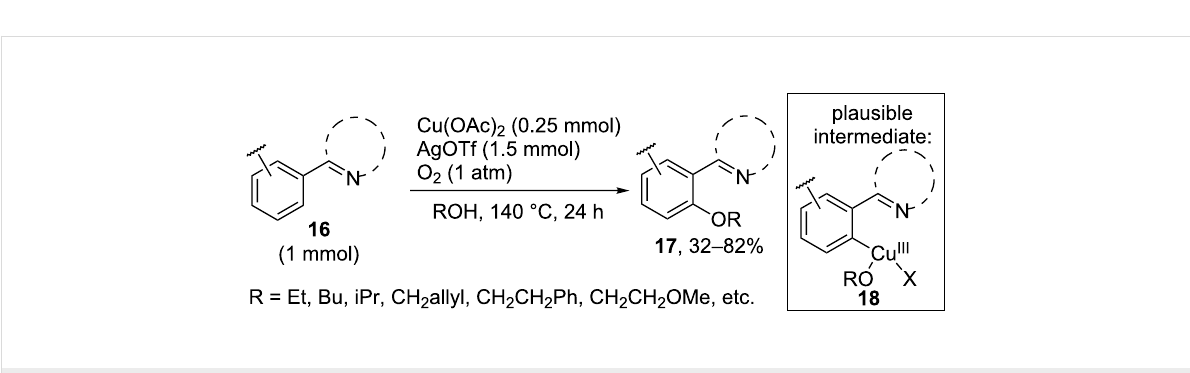
Scheme 5: Cu(OAc) 2 /AgOTf/O 2 oxidative system in the ortho -alkoxylation of